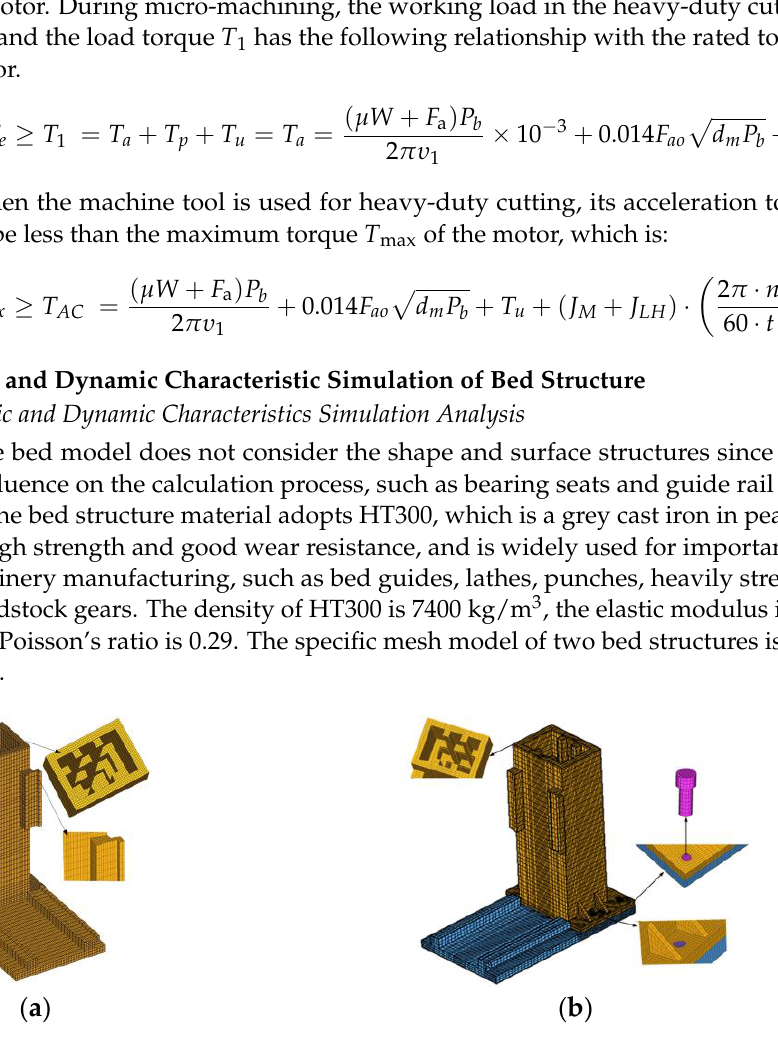
Figure 8. Mesh models of two bed structures. ( a ) Monolithic structure. ( b ) Separate structure.